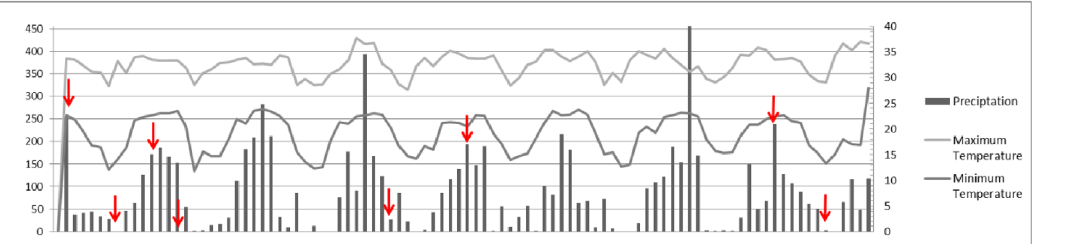
Fig 2. Meteorological data from the Nhumirim Ranch. Precipitation (left axis) and maximum and minimum average temperatures between February 2005 and December 2012 (right axis). The arrows indicate the peak periods of drought and rain that we selected for the